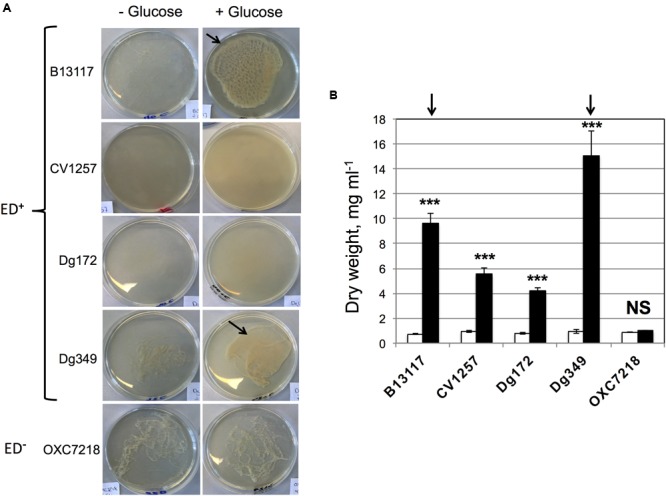
Glucose stimulates production of floating biofilm that increases cell biomass. (A) The isolates of C. coli shown were cultivated for 4 days at 37°C under microaerobic conditions in glucose-free TSB with and without supplementation with 100 mM glucose. The glucose-supplemented cultures of B13117 (ED+) and Dg349 (ED+) formed extensive floating biofilm (flocs; arrowed). CV1257 (ED+) and Dg172 (ED+) displayed denser growth with glucose but no biofilm formation, while a low level of aggregation was seen in the cultures of ED-negative OXC7218 regardless of glucose-supplementation. Pictures are representative cultures from four independent growths. (B) The four ED-positive C. coli isolates (B13117, CV1257, Dg172, and Dg349) and the ED-negative C. coli strain OXC7218 were cultivated for 7 days at 37°C under microaerobic conditions in glucose-free TSB with or without glucose supplementation. The bars show dry weight biomass of 5 ml aliquots from cultures without glucose (white bars) and with glucose supplementation (black bars). The mean and standard deviations of four independent cultures for each condition are shown. The statistical significance of the difference between the dry weight without glucose and with added glucose was evaluated by Student’s t-test, as indicated by (∗∗∗p < 0.001) or NS (not significant). The arrows refer to the biofilm producing strains B13117 and Dg349 as in (A), which clearly produce more biomass with glucose compared to the other non-biofilm producing strains tested.